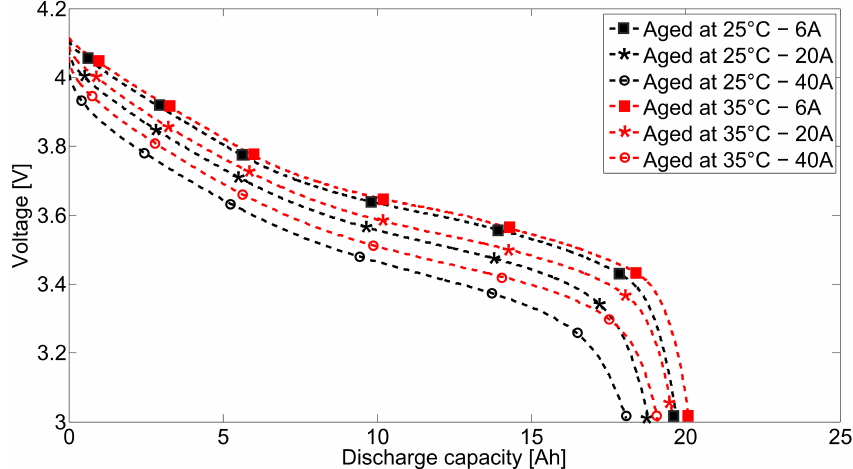
Figure 11. Discharge capacity at 25 ◦ C and 35 ◦ C of the cell 2 at various current